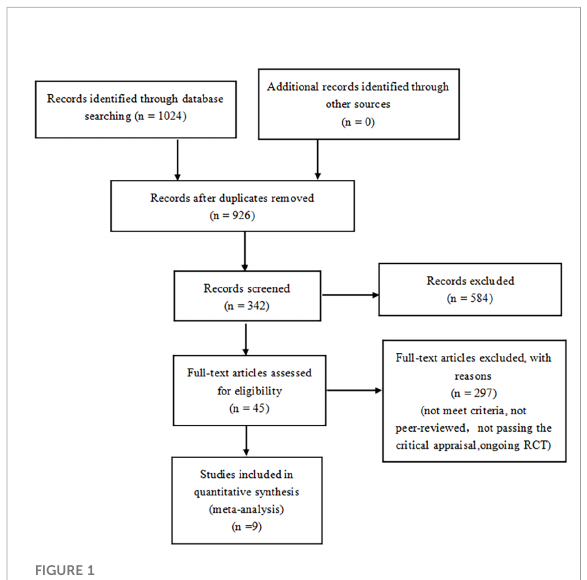
FIGURE 1 Flow diagram of study